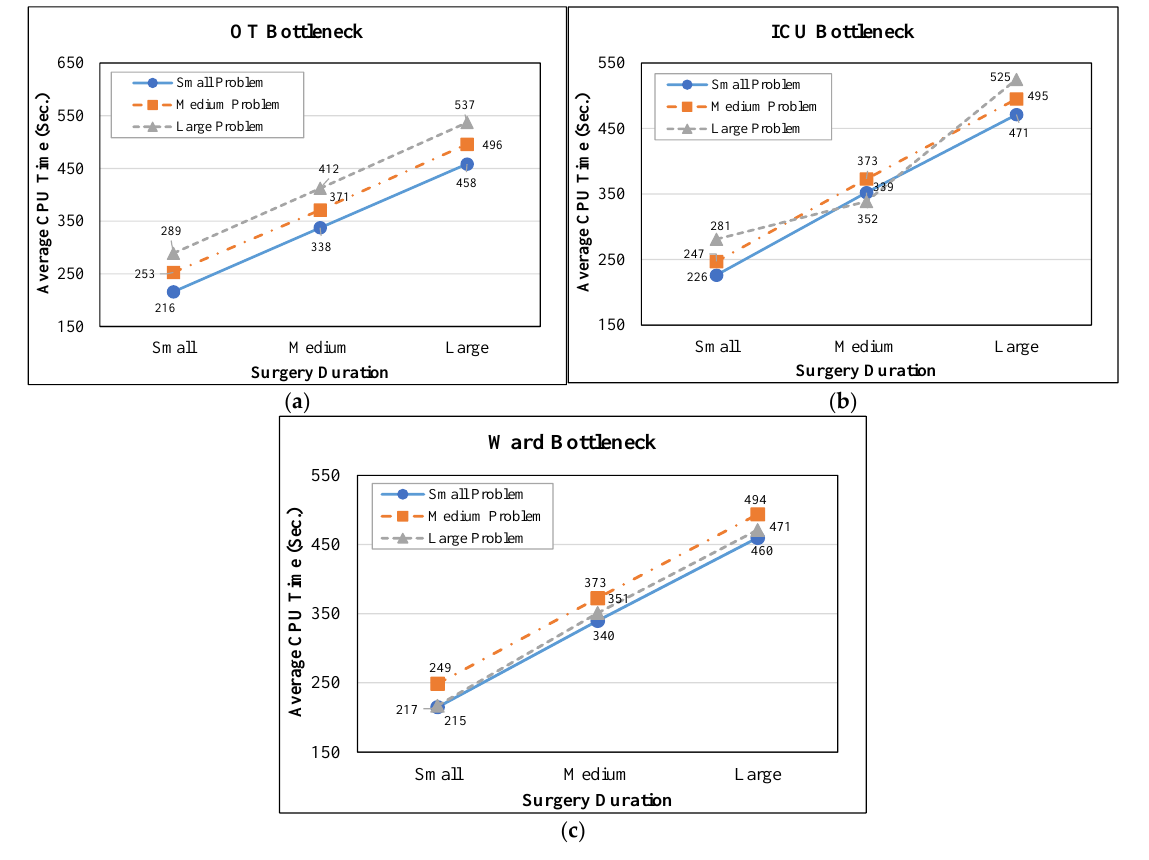
Figure 6. CPU time for each category of problem: ( a ) operating room is the bottleneck, ( b ) ICU is the bottleneck, and ( c ) ward is the bottleneck.